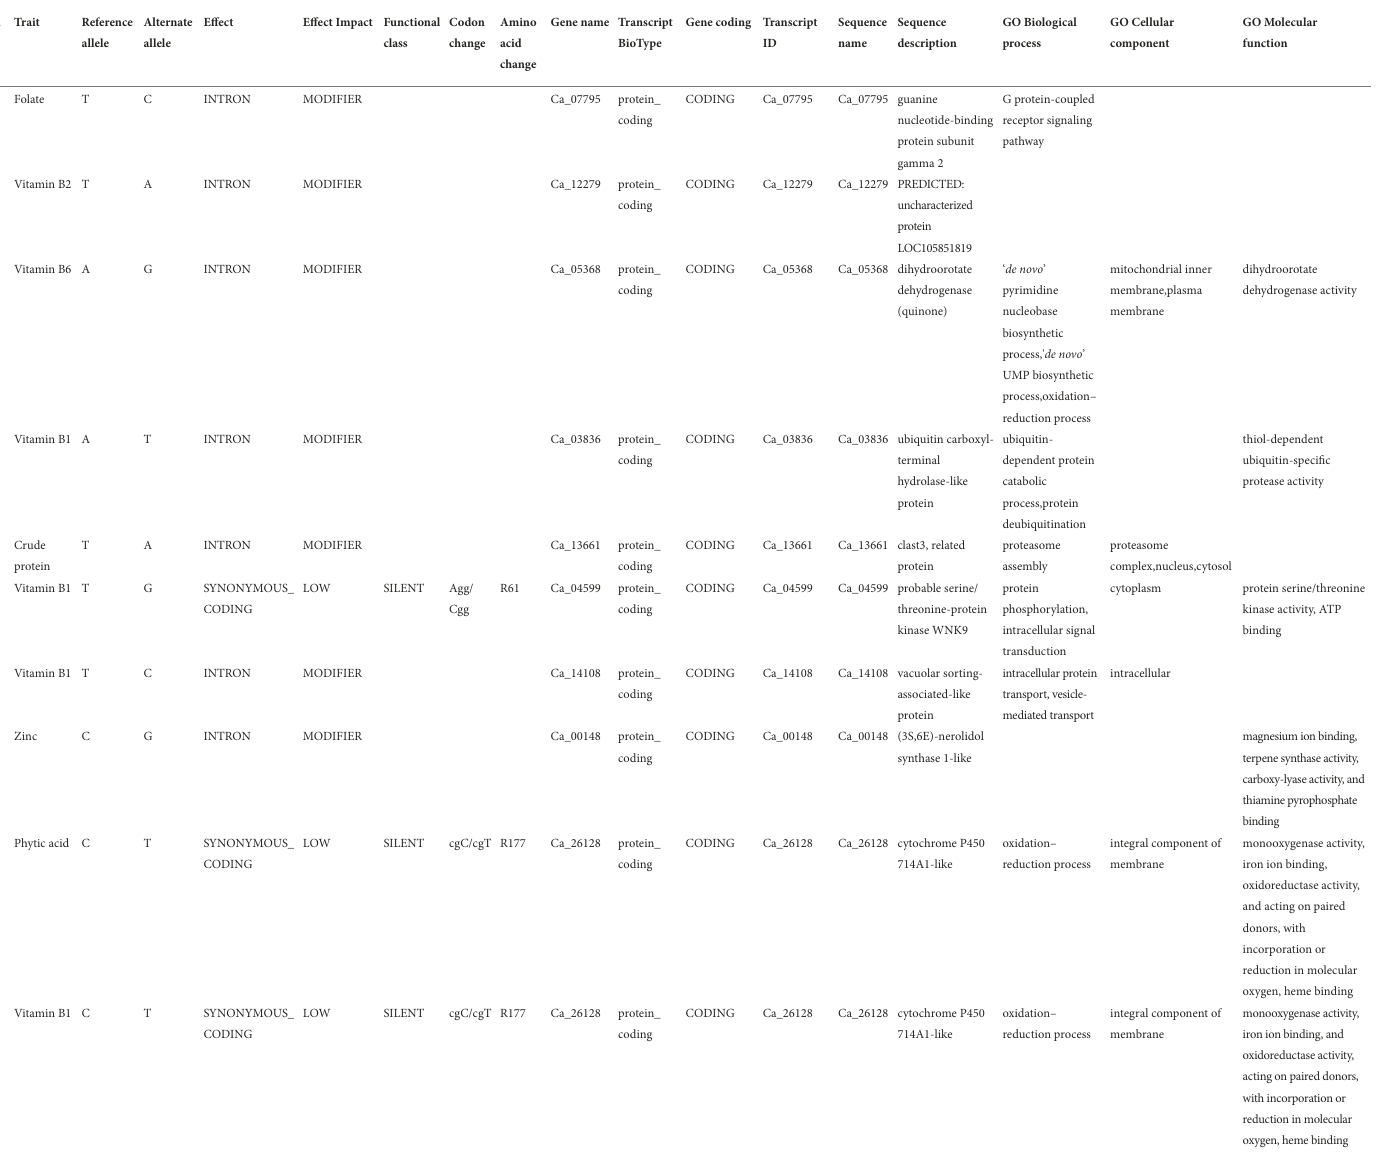
TABLE 3 Candidate gene analysis for significant MTAs detected for 12 nutritional traits in the chickpea reference set